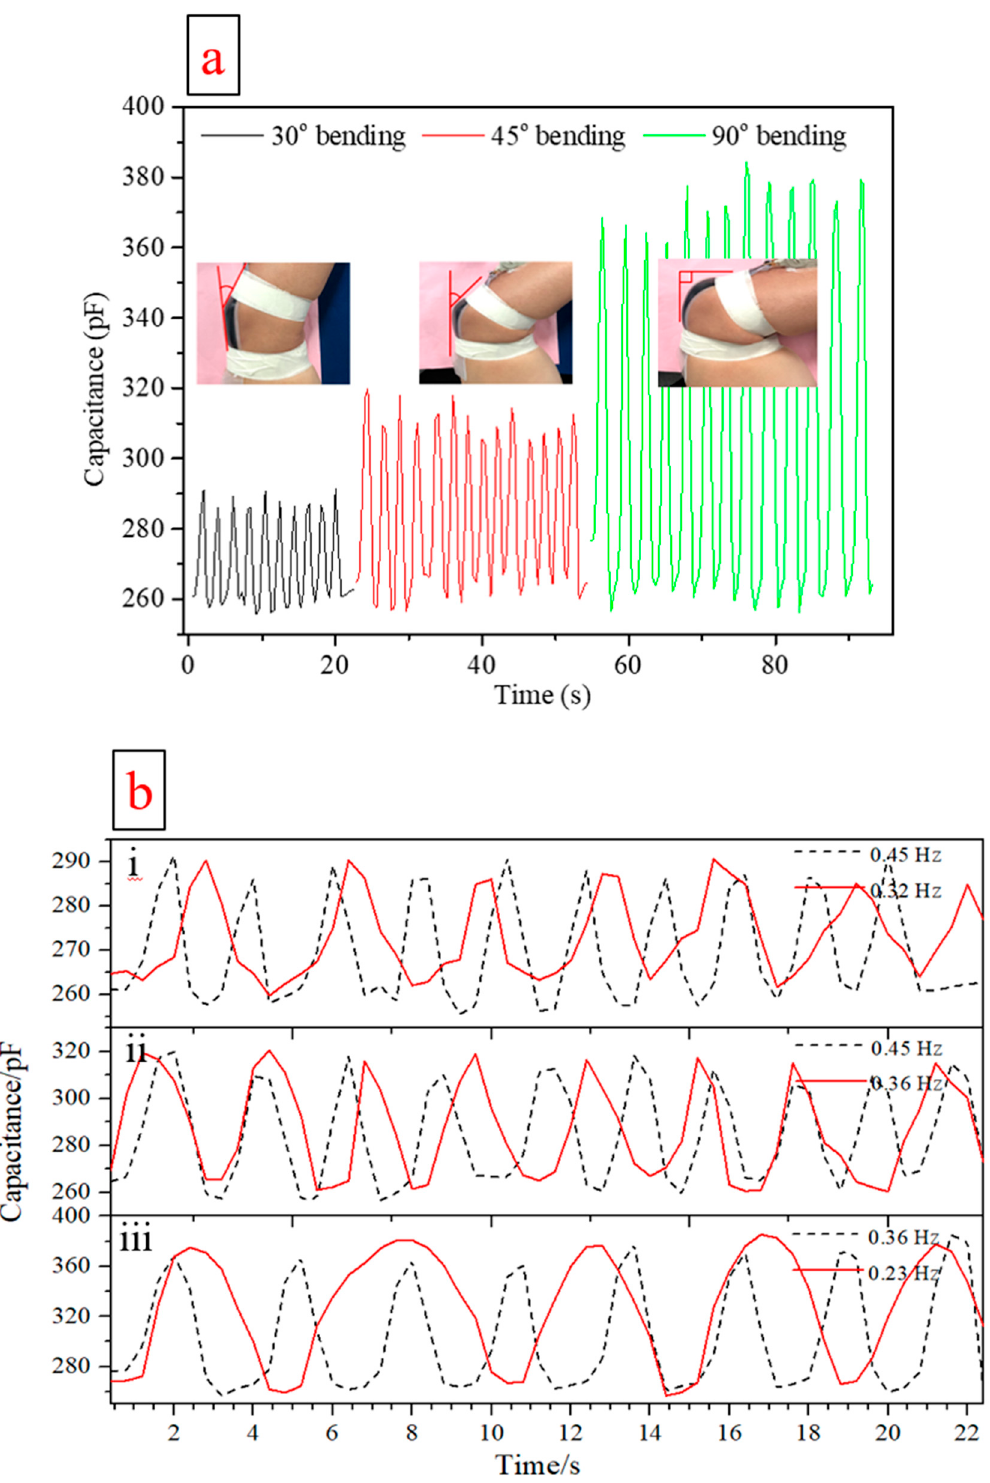
Figure 8. ( a ) Typical capacitance changes recorded with the flexible sensor when monitoring human elbow motion over different flexion angles. ( b ) Sensor capacitance signals recorded during elbow elbow motion over di ff erent flexion angles. ( b ) Sensor capacitance signals recorded during elbow flexion at di ff erent motion frequencies; (b-i) for 30 ◦ elbow bending; (b-ii) for 45 ◦ elbow bending; (b-iii) flexion at different motion frequencies; (b-i) for 30° elbow bending; (b-ii) for 45° elbow bending; (b- for 90 ◦ elbow iii) for 90° elbow bending.